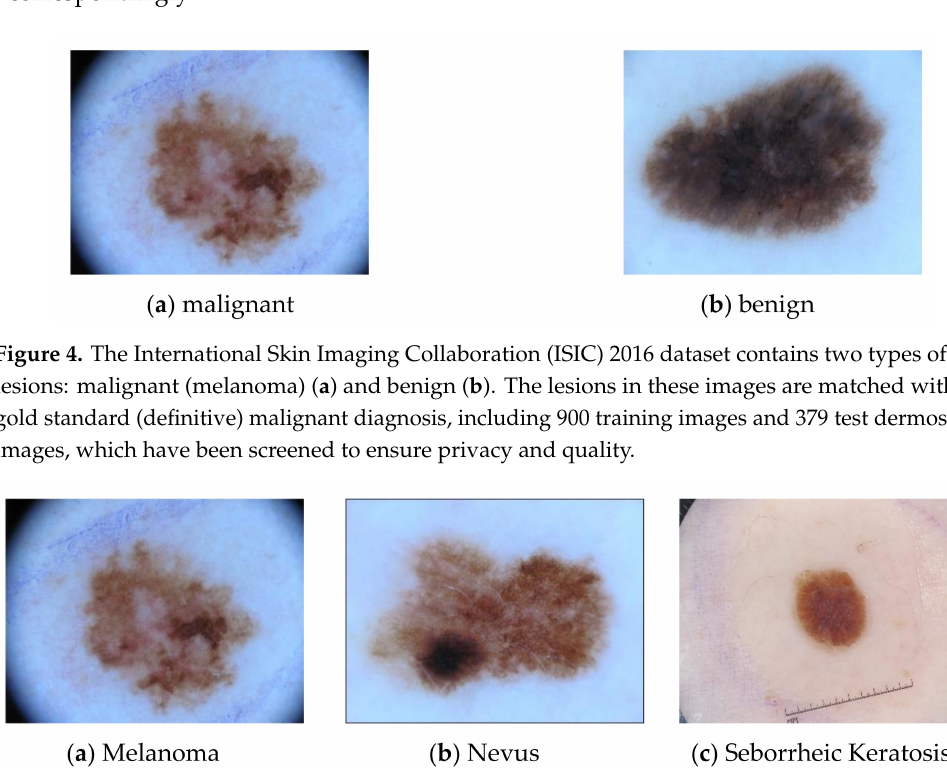
Figure 5. The lesion images in the ISIC 2017 dataset of the International Skin Imaging Collaboration are divided into three categories: melanoma ( a ), nevus ( b ) and seborrheic keratosis ( c ). This includes 2000 training, 150 verification and 600 test dermoscopy lesion images, which are all paired with gold standard diagnoses and ensure privacy and quality.